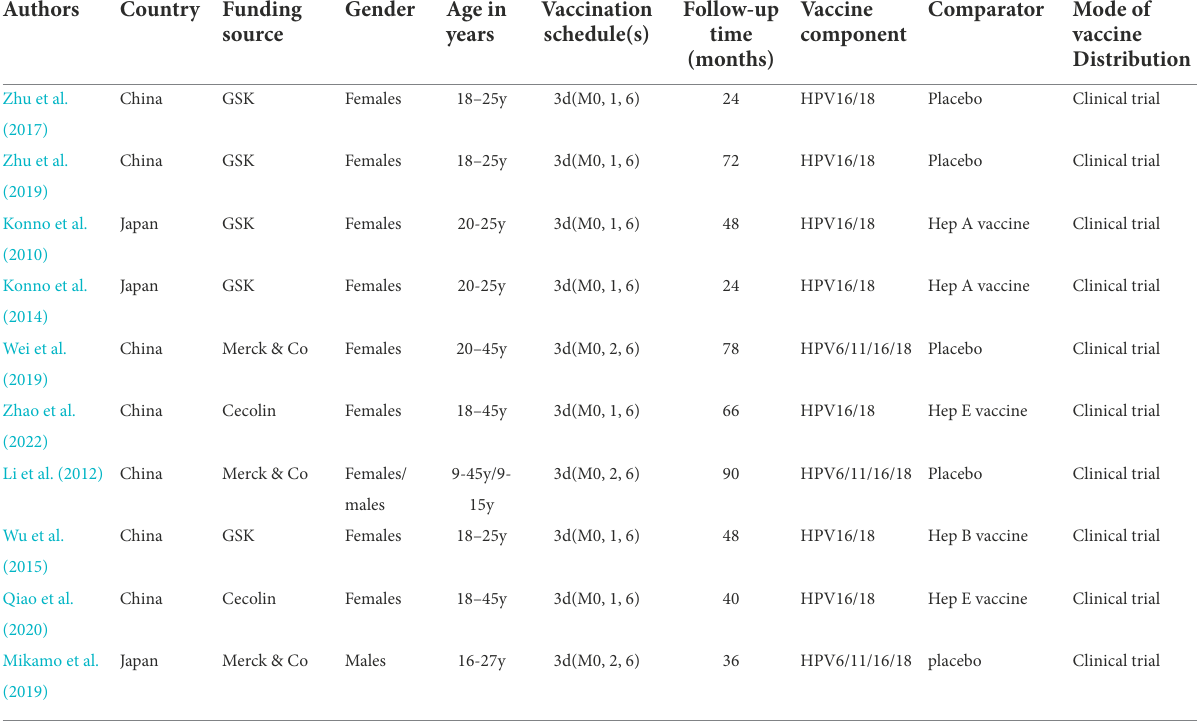
TABLE 1 Descriptive characteristics of the studies included in the review.